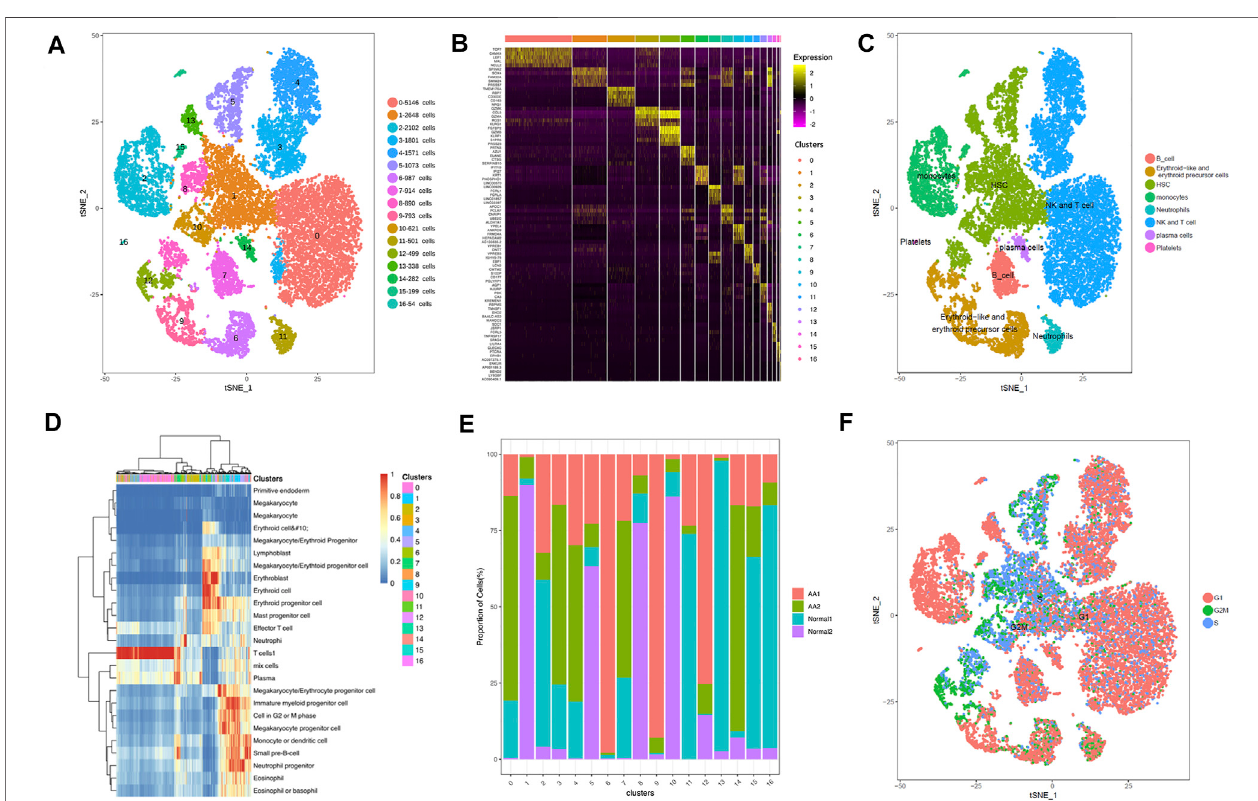
FIGURE1| OverviewofcellheterogeneityinsamplesfromAApatients andhealthydonors.Totally17cellclusterswereidenti fi edbyscRNA-seq. (A) Totally17cell clusters were identi fi ed by heat-distributed stochastic neighbor embedding (tSNE). (B) Marker genes of each cell cluster. (C) Cell type identi fi cation and distribution in each cell cluster. (D) Heatmap depicting representative differentially expressed genes from each cell cluster. (E) Proportions of cell clusters in each sample. (F) Cycle of each cell cluster.